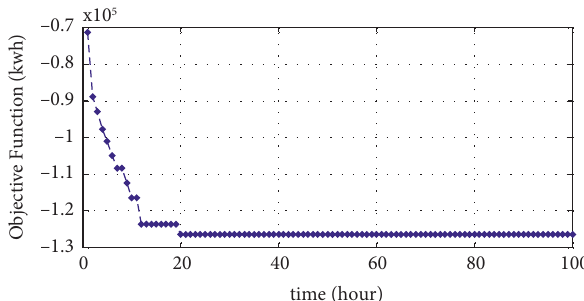
Figure 12: Optimal islanding formation in case